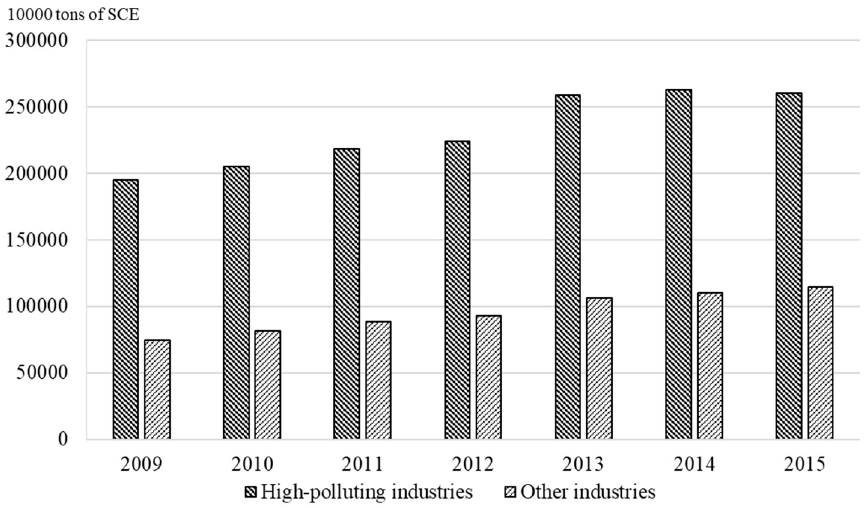
Figure 1. Energy consumption of different industries in China.